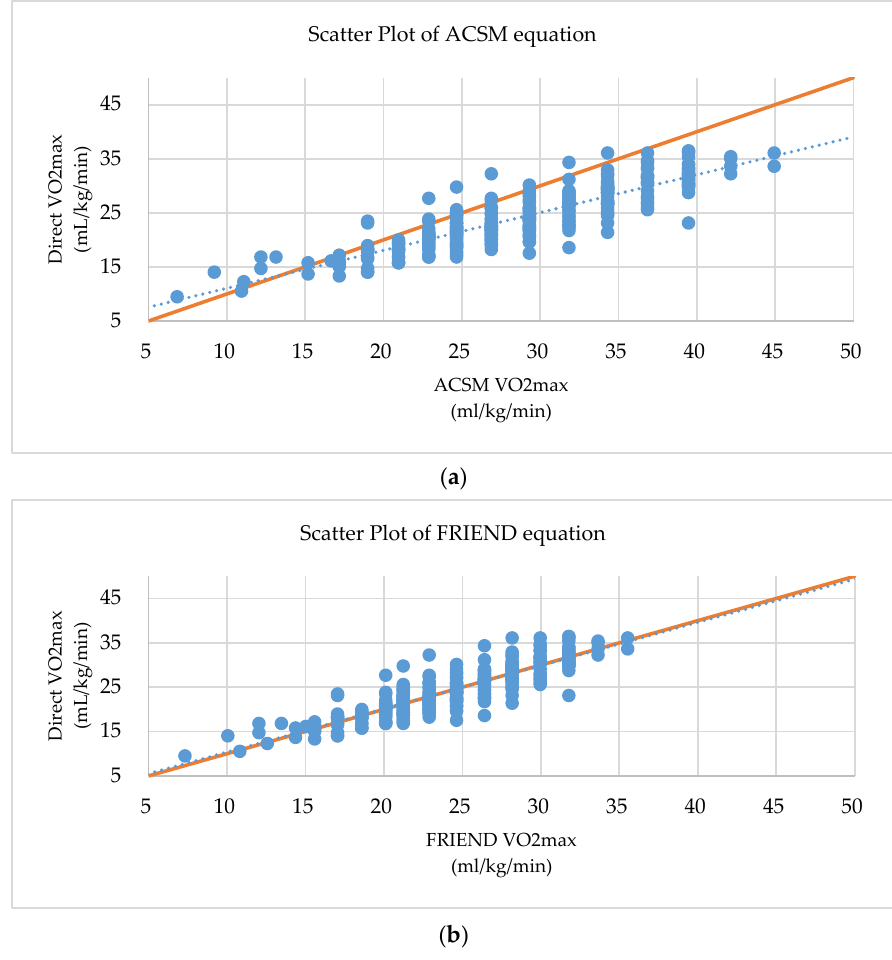
Figure 3. Scatter Plot between directly measured CRF and estimated CRF: ( a ) Scatter plot between directly measured CRF and estimated CRF by ACSM ( b ) Scatter plot between directly measured CRF and estimated CRF by FRIEND equation. Dotted line; linear regression line, Solid line; 1:1 reference line. Table 4. Equivalence analysis of the ACSM equation and the FRIEND equation.